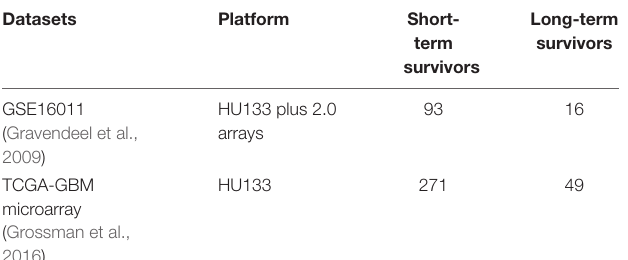
TABLE 6 | Statistics of the two validation datasets. Datasets Platform Short-